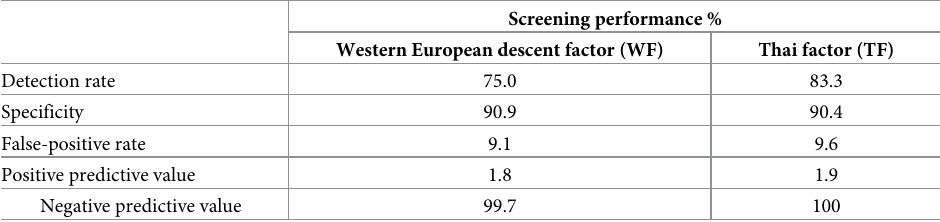
Table 3. Comparison of quadruple maternal serum screening performance between using the Western European descent factor (WF) and the Thai factor (TF) for calculation.